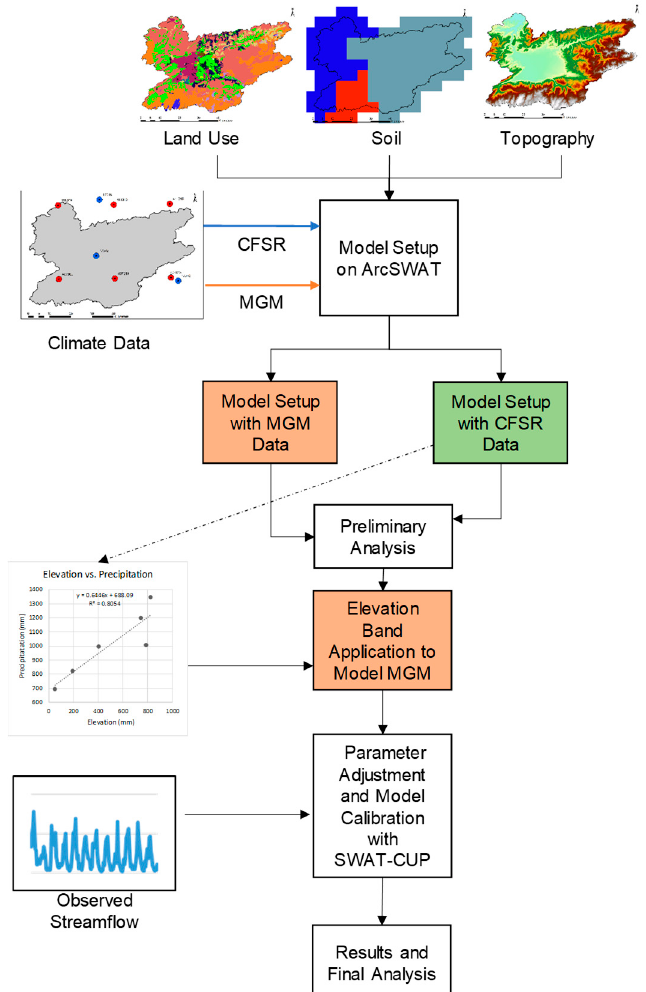
Figure 3. Schematic representation of methodology used in the study.